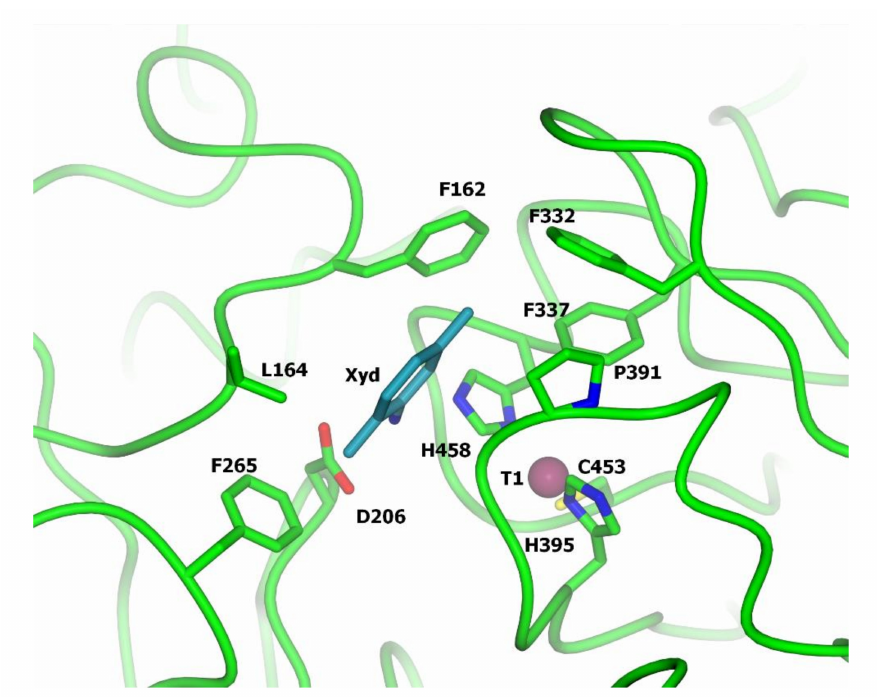
Figure 5. Substrate-binding pocket of T. versicolor laccase (structure of the laccase complex with 2,5-xylidine, PDB 1KYA